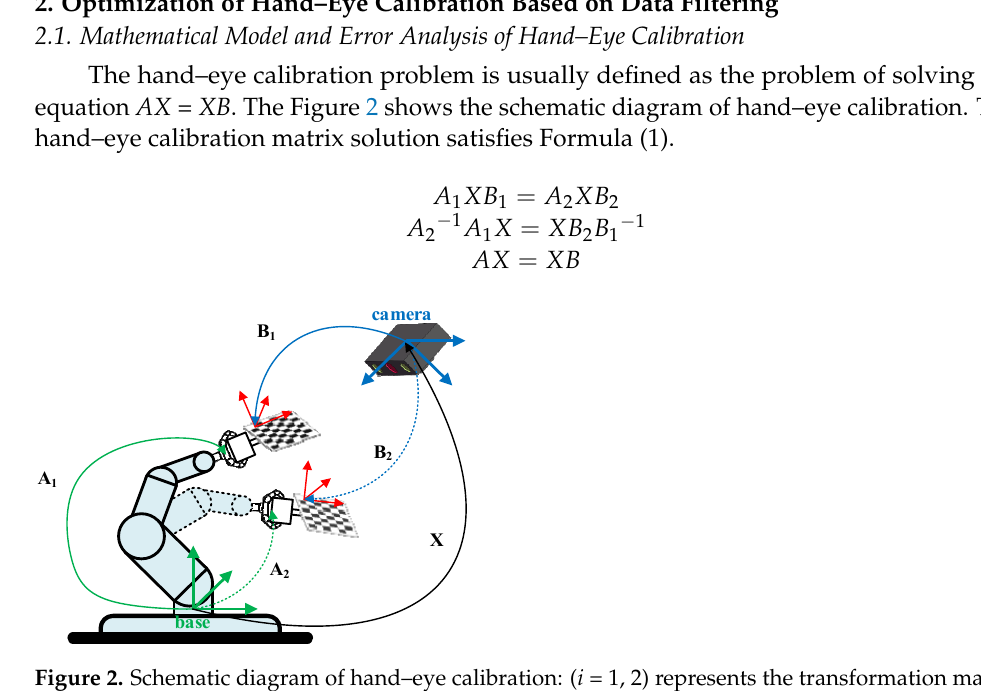
3 of 18 Figure 1. Workflow of automatic robotic assembly system. The transformation relationship between the robot and the camera is obtained through hand–eye calibration. Through point cloud segmen- tation and point cloud registration, the pose of the target in the camera coordinate system is calcu-